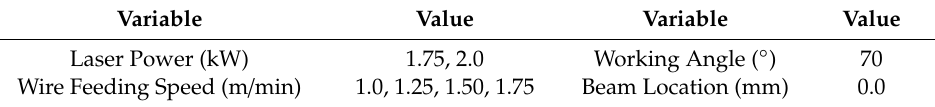
Table 7. Welding conditions of Step 3 (laser power change, wire feeding speed change, 6 cases).